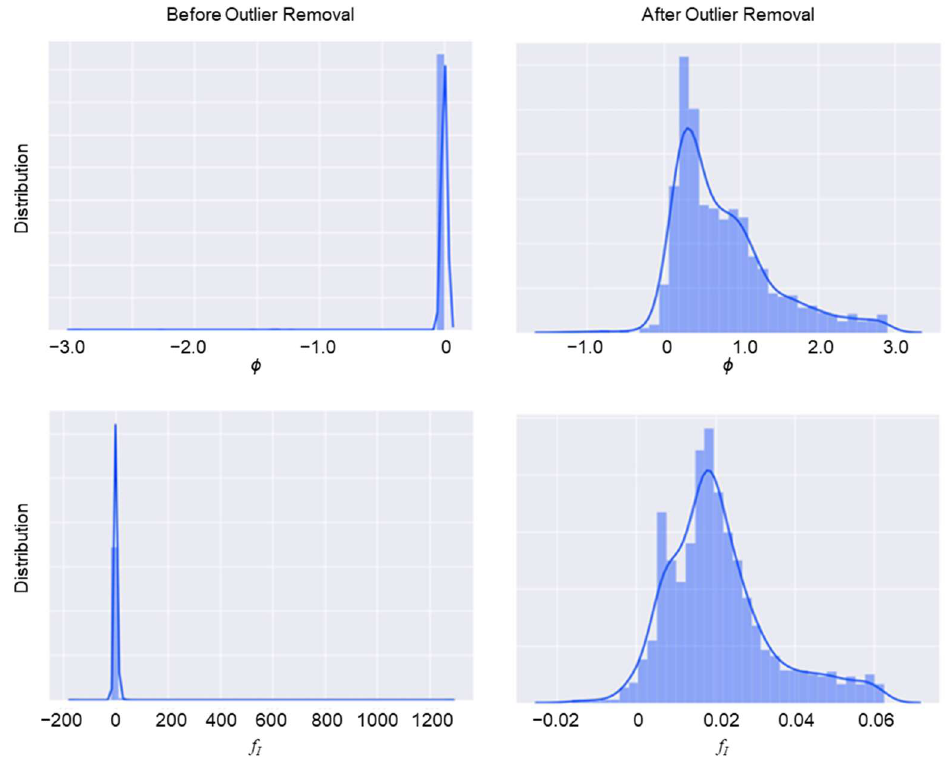
Figure 5. Comparison of the distribution for ϕ (top) and f I (bottom) before (left column) and after (right column) the outliers were removed.